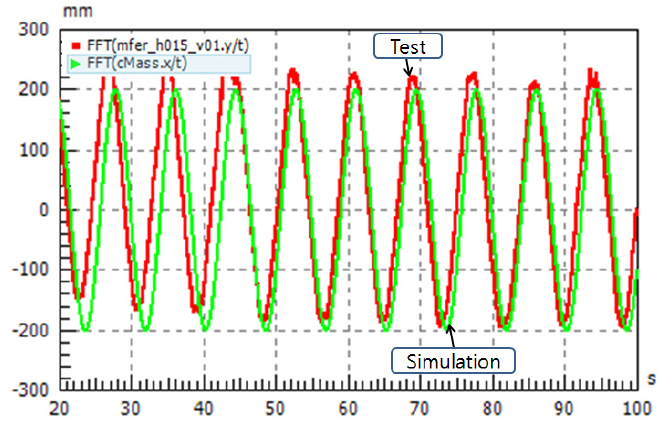
Figure 7. Excitation displacement input condition.